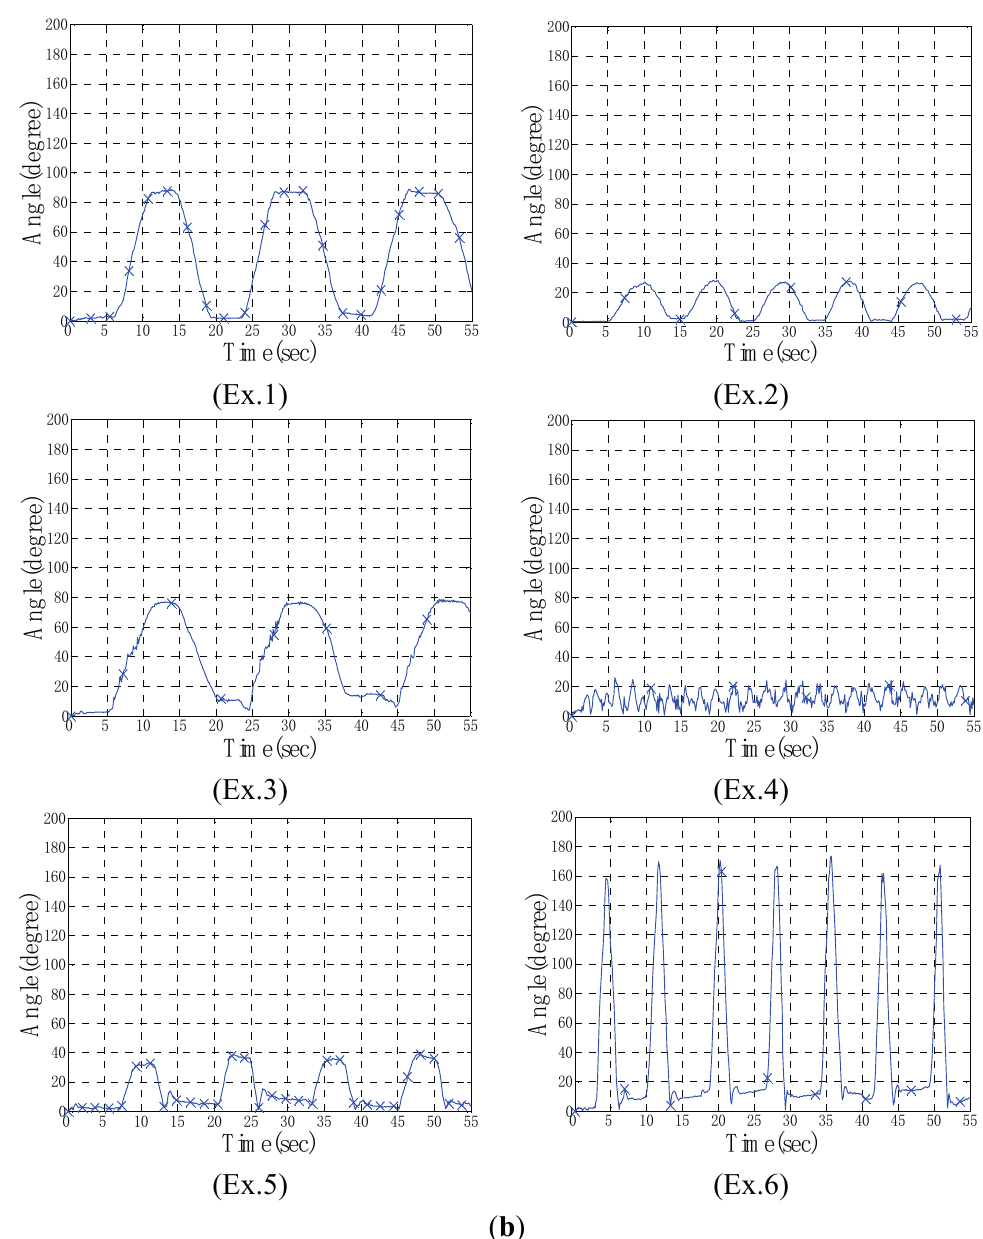
Figure 4. Variation of signals of Node 2 measured using ISNs for the six exercises. ( a ) Acceleration group; ( b ) Included angle group derived by